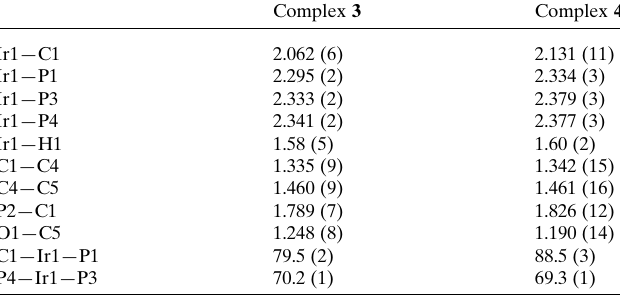
Table 1 Selected distances and angles (A˚ , (cid:3) ) in complexes 3 and 4 .